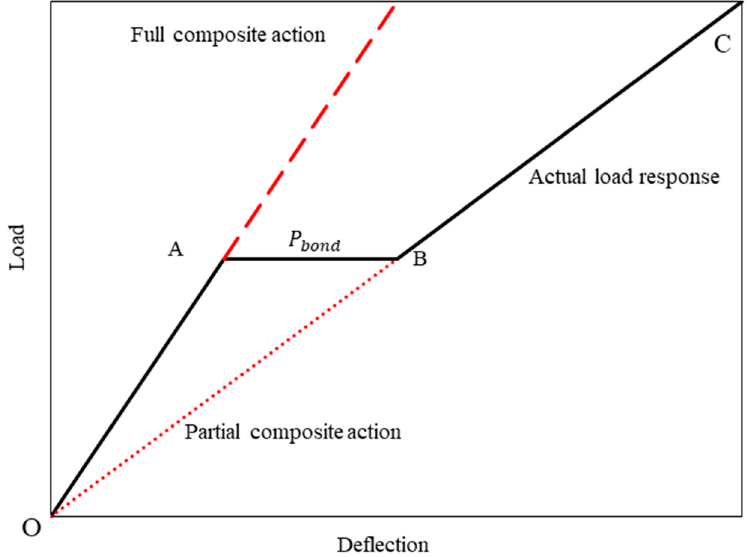
Figure 14. Idealized load response considering the three-stage shear force-slip relationship.